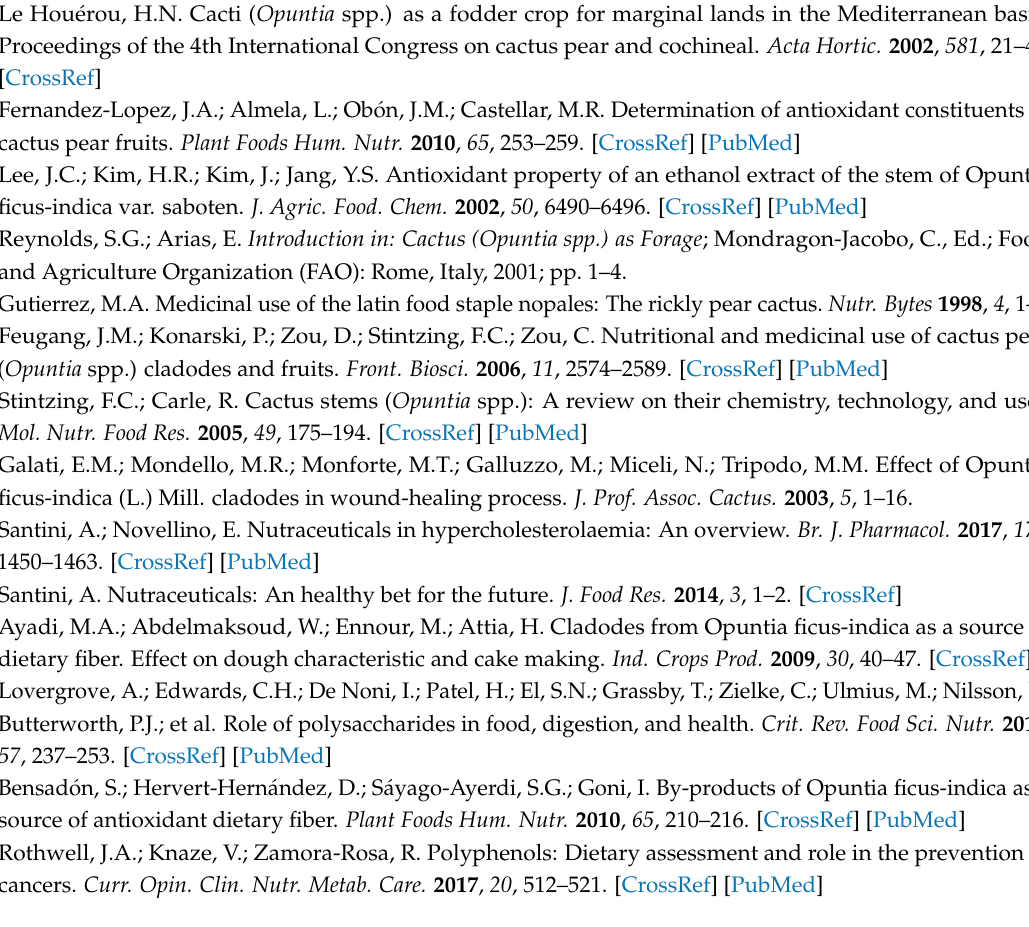
Table S1: Whole dataset of phenolic compounds identified in cladode extracts, together with relative abundances and annotations (raw formula, identification score, composite